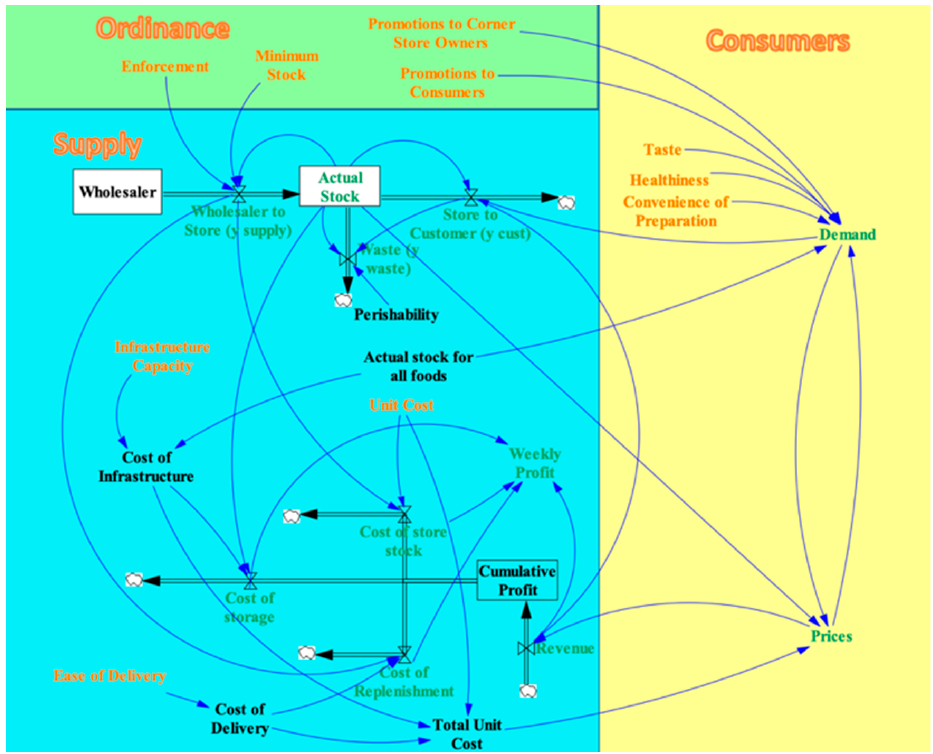
Figure 5. The complete SFO Visual Model with input and result variables highlighted.